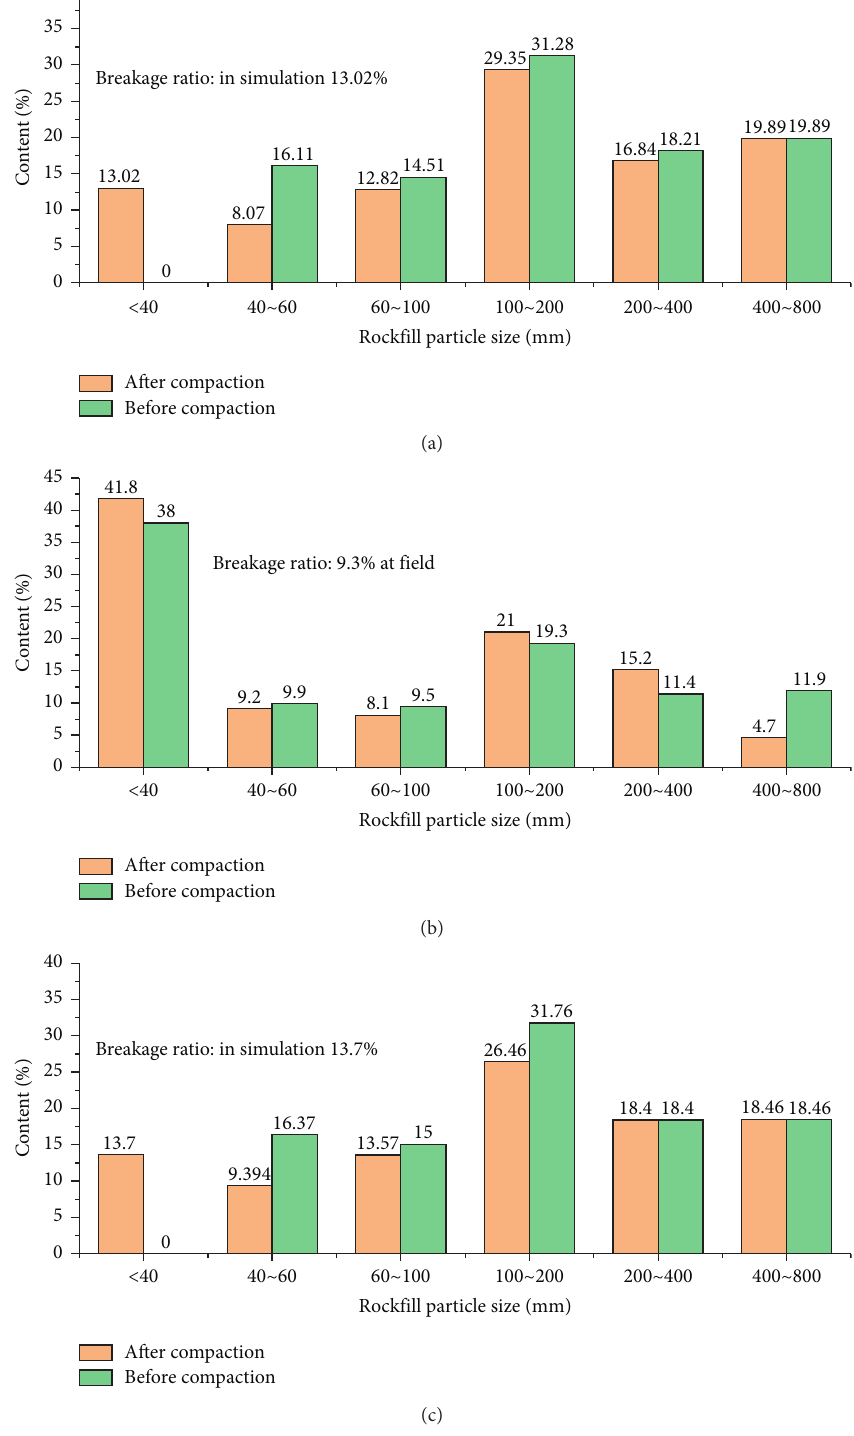
Figure 20: PSD analysis of rockfill particles in case B and case C. (a) Case B NUM. (b) Case B EXP. (c) Case C